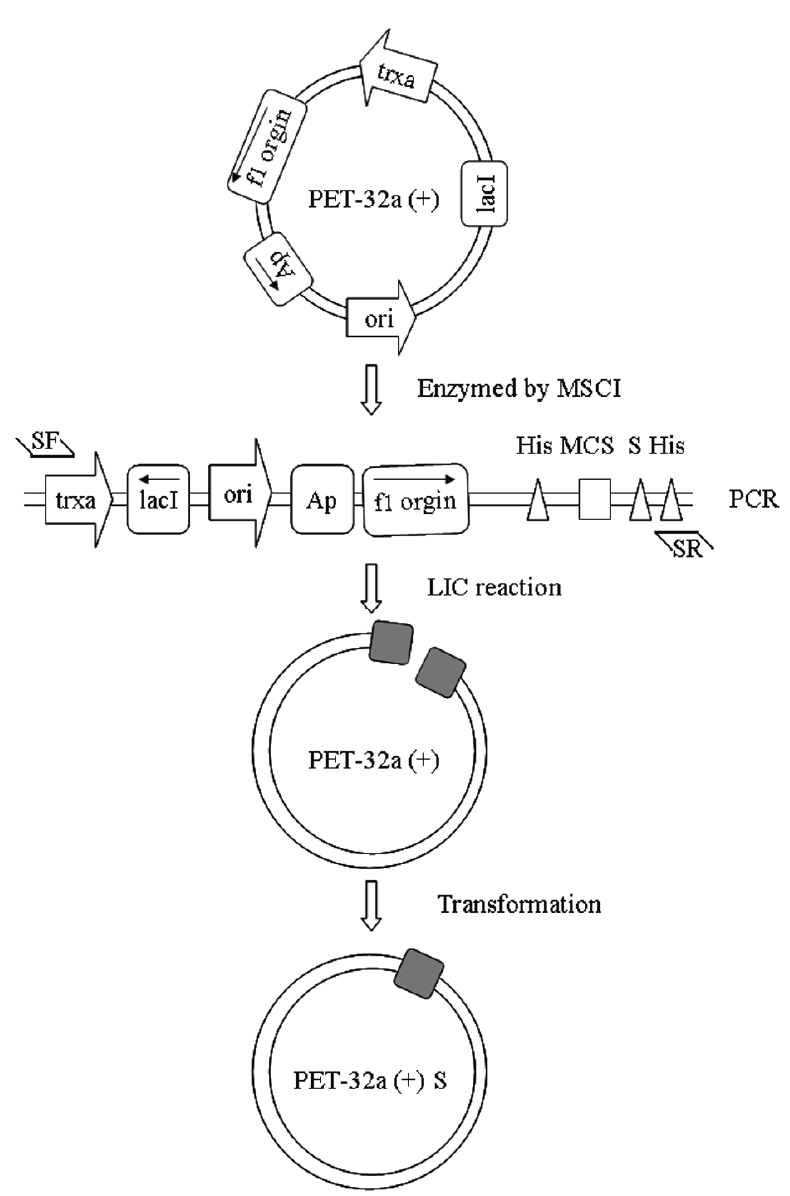
Figure 7. Vector